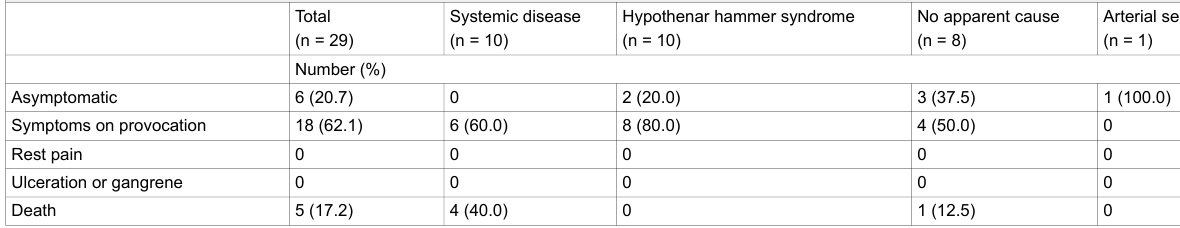
Table 4: Severity of symptoms and signs at 5-years